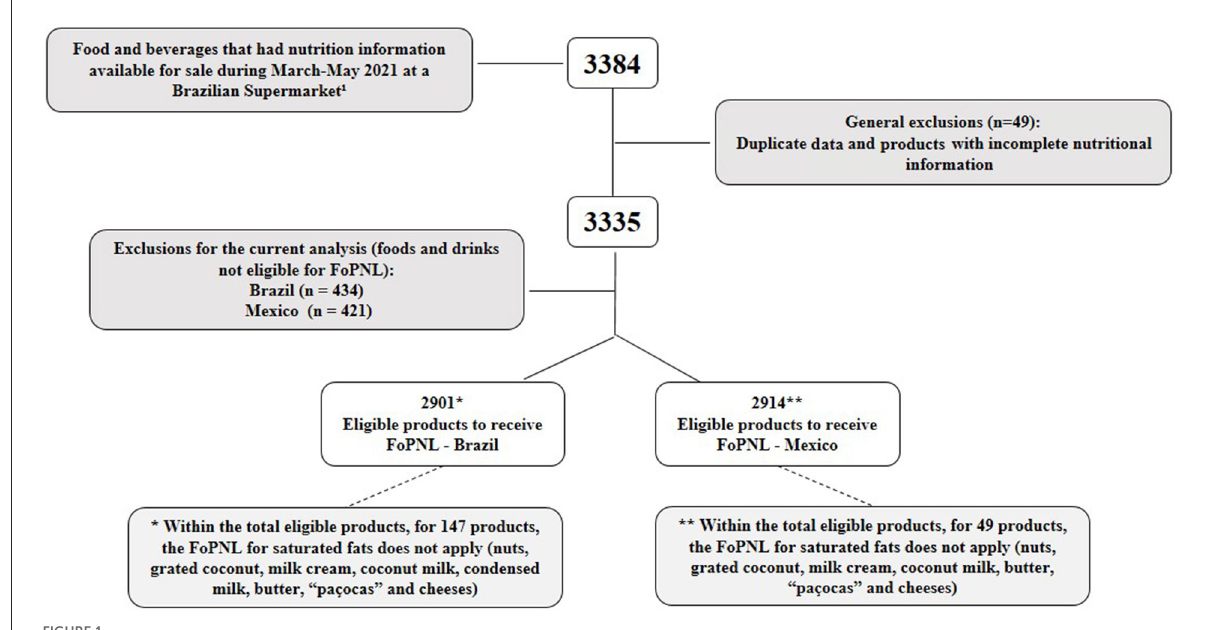
FIGURE1 Number of initial and final products that were collected and used in the present study. 1 Information table is not currently required for alcoholic beverages, food additives, and technology adjuvants the spices; natural mineral waters ans other waters for human consumption; to vinegars; to salt (sodium chloride); coffee, yebra mate, tea, and other herbs without the addition of other ingredients; food prepared and packed in restaurants and establishments commercial, ready for consumption; Fractionated products at retail points of sale, marketed as pre-measured; fresh, chilled, and frozen fruits, vegetables, and meats; food with packaging whose visible surface for labeling is ≤ 100cm 2